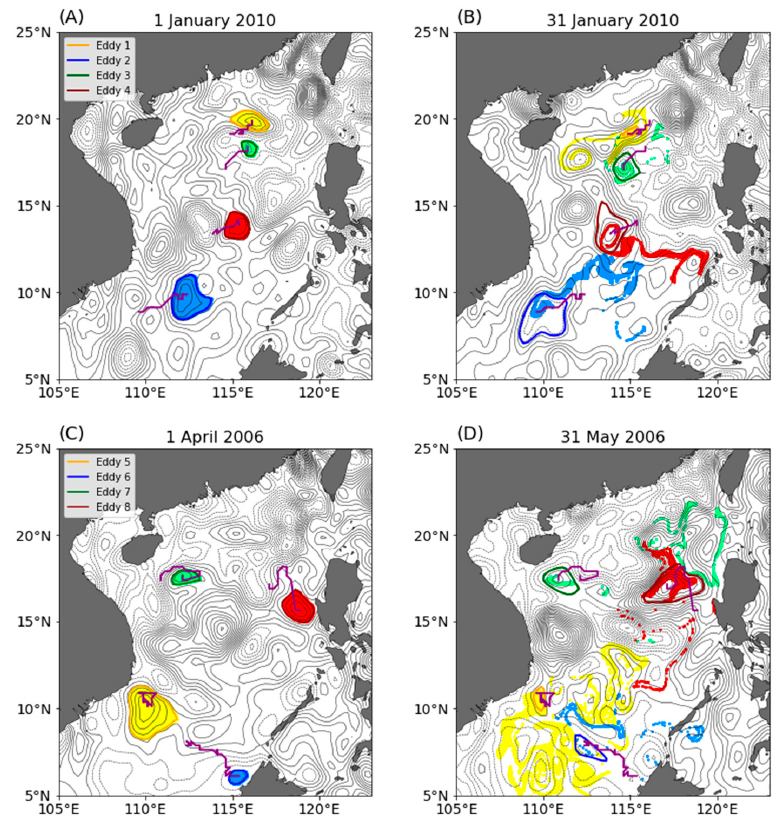
Figure 4. The initial (left panels) and final (right panels) particle locations of randomly selected eddies that live for longer than ( A , B ) 30 and ( C , D ) 60 days. Colored contours are eddy boundaries defined by SSH contours. Colored dots represent the initial particles inside the eddy boundaries. Purple lines indicate eddy center trajectories.